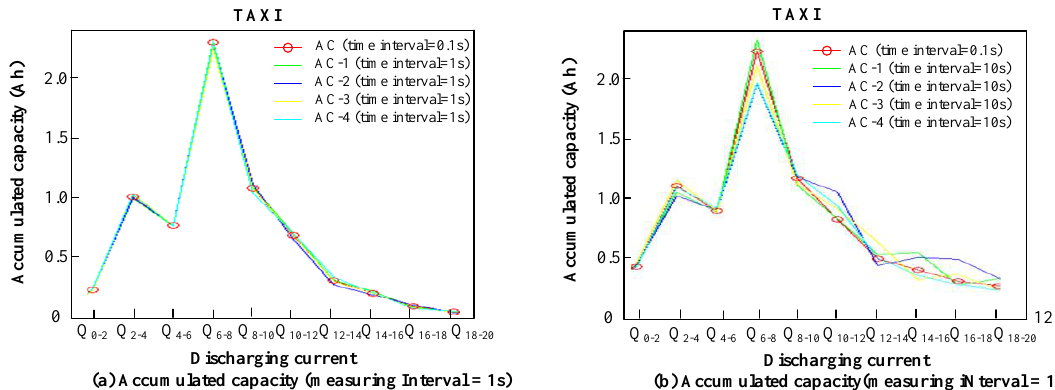
Figure 11. Accumulated capacities for different discharging currents. ( a ) Measuring interval = 1 s; ( b ) Measuring interval = 10